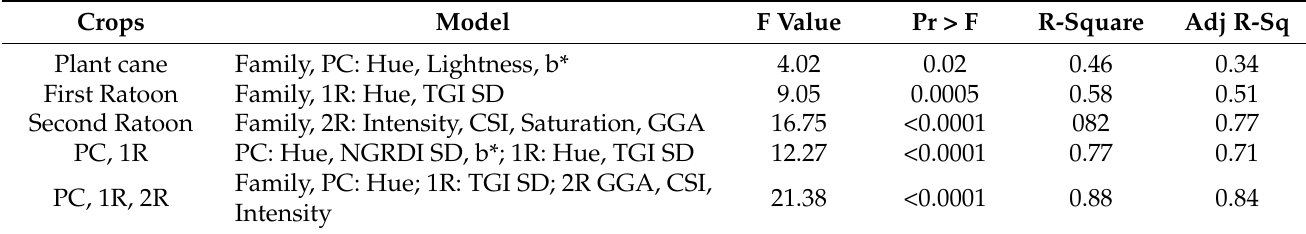
Table 6. Factors used in multiple linear regression with the statistics of different multiple regression models with second ratoon plot weight as a response